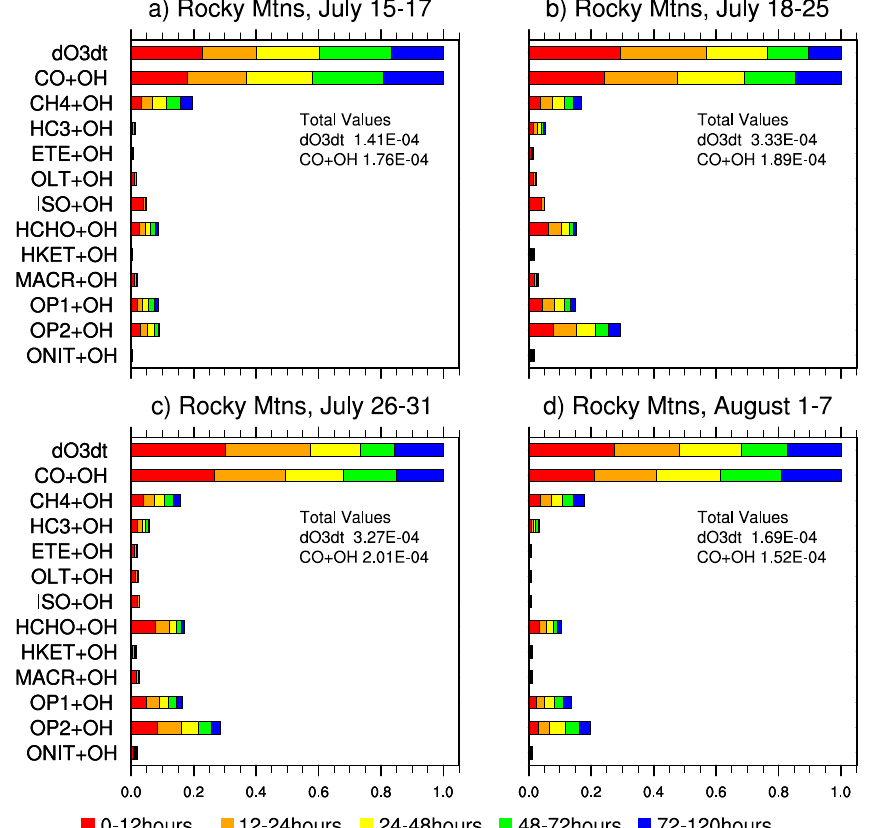
Fig. 11. The contribution of various VOC oxidation reactions to peroxy radical formation is shown as a function of the age of air for the Rocky Mountain region. Each contribution is an average for the upper troposphere (8–12km altitude range) over the four time periods described in the meteorology section of the paper. The dO 3 dt and CO + OH rates are normalized by their total value (listed in the panel) in the region and time period, while the other reaction rates are normalized by the CO + OH total value in the region and time period. The Rocky Mountain region is shown in Fig.